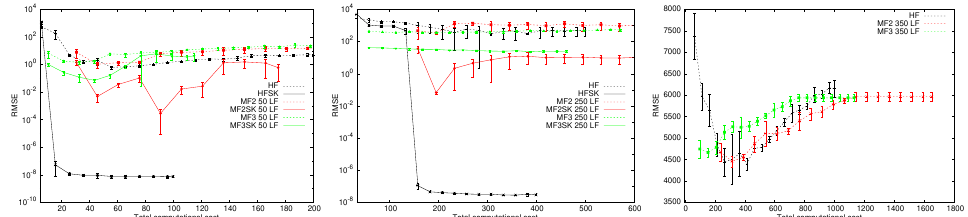
Figure 12. Kriging: Rosenbrock function RMSE (from left to right, two, five and ten dimensions). Ordinary and SPCE-Kriging in dashed and solid lines, respectively.